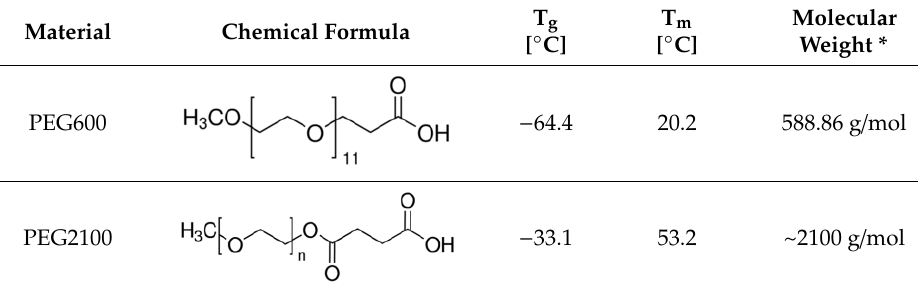
Table 4. Properties of Polyethylene Glycols Used in This Study.